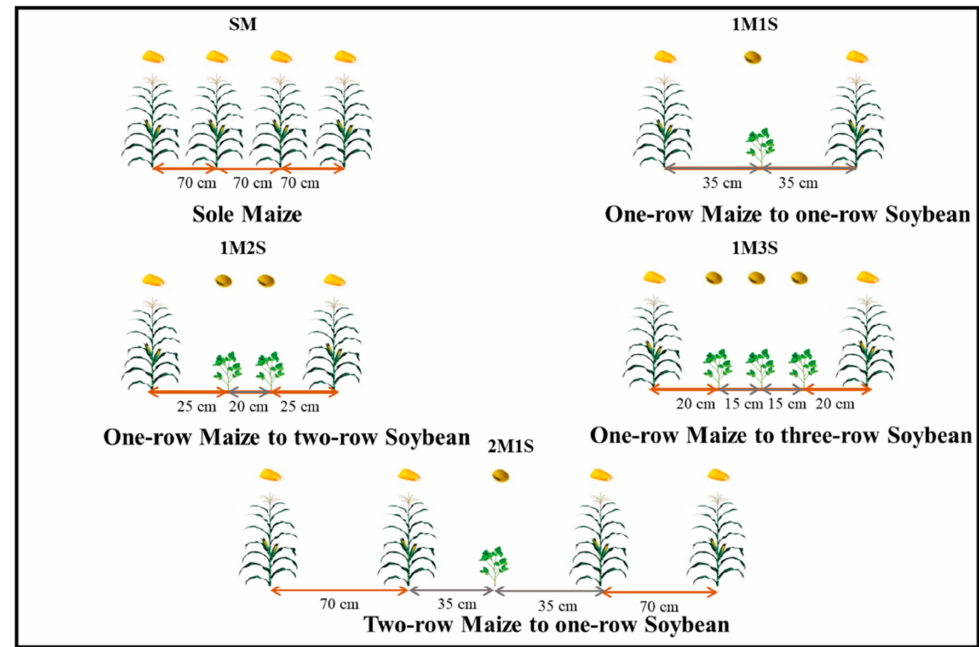
Figure 2. Schematic illustration of row layout of maize and intercropped maize-soybean in the experimental planting